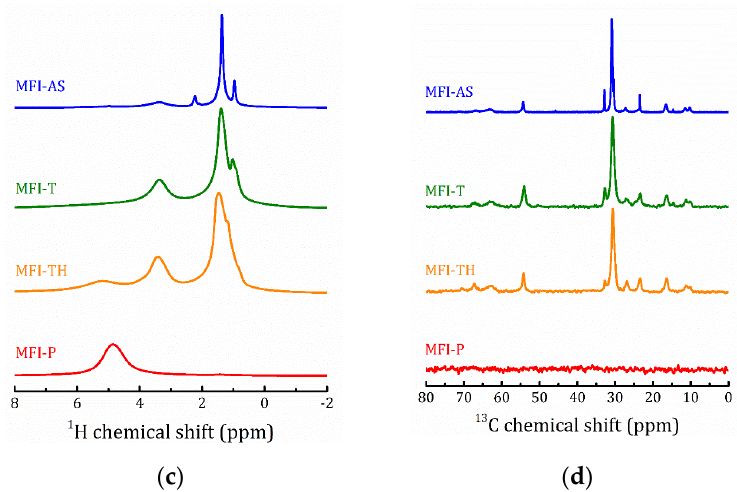
Figure 7. 1 H MAS NMR ( a , c ) and 13 C CP/MAS NMR at τ cp = 2 ms ( b , d ) spectra of the studied MOR ( a , b ) and MFI ( c , d ) samples at all the preparation steps.